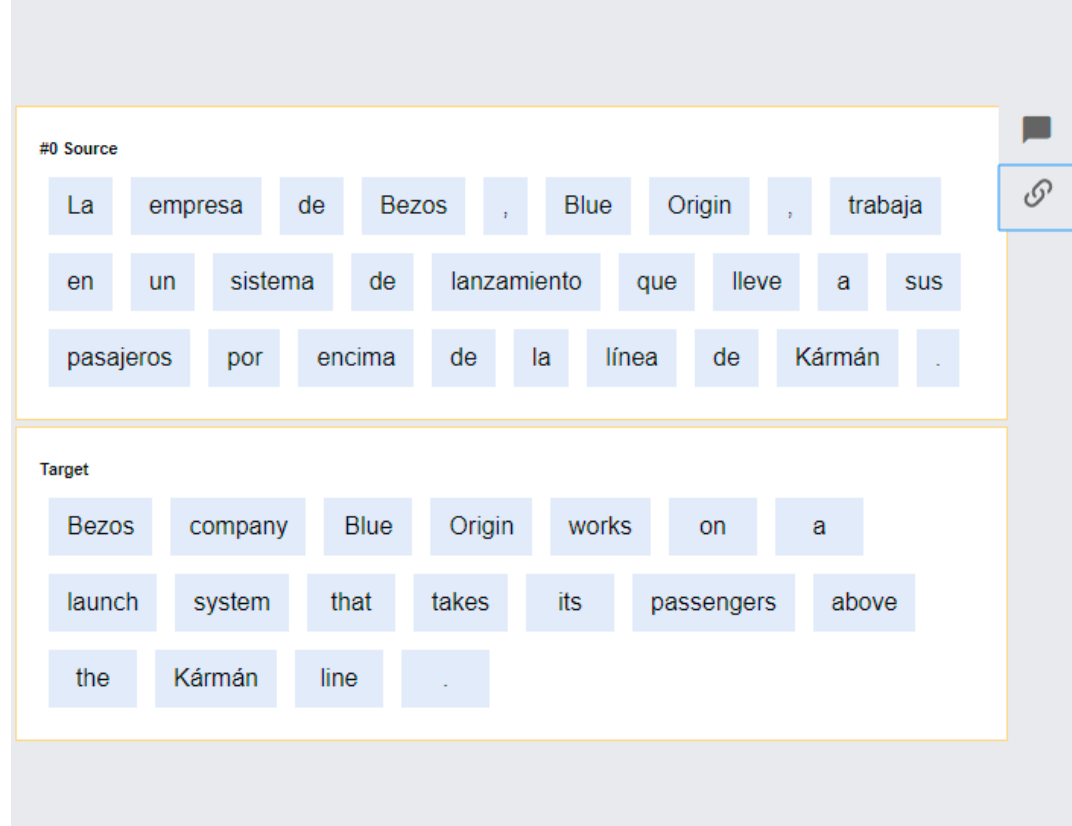
Figure 4. Interface of our initial prototype showing the Tile view, designed for touch interaction.